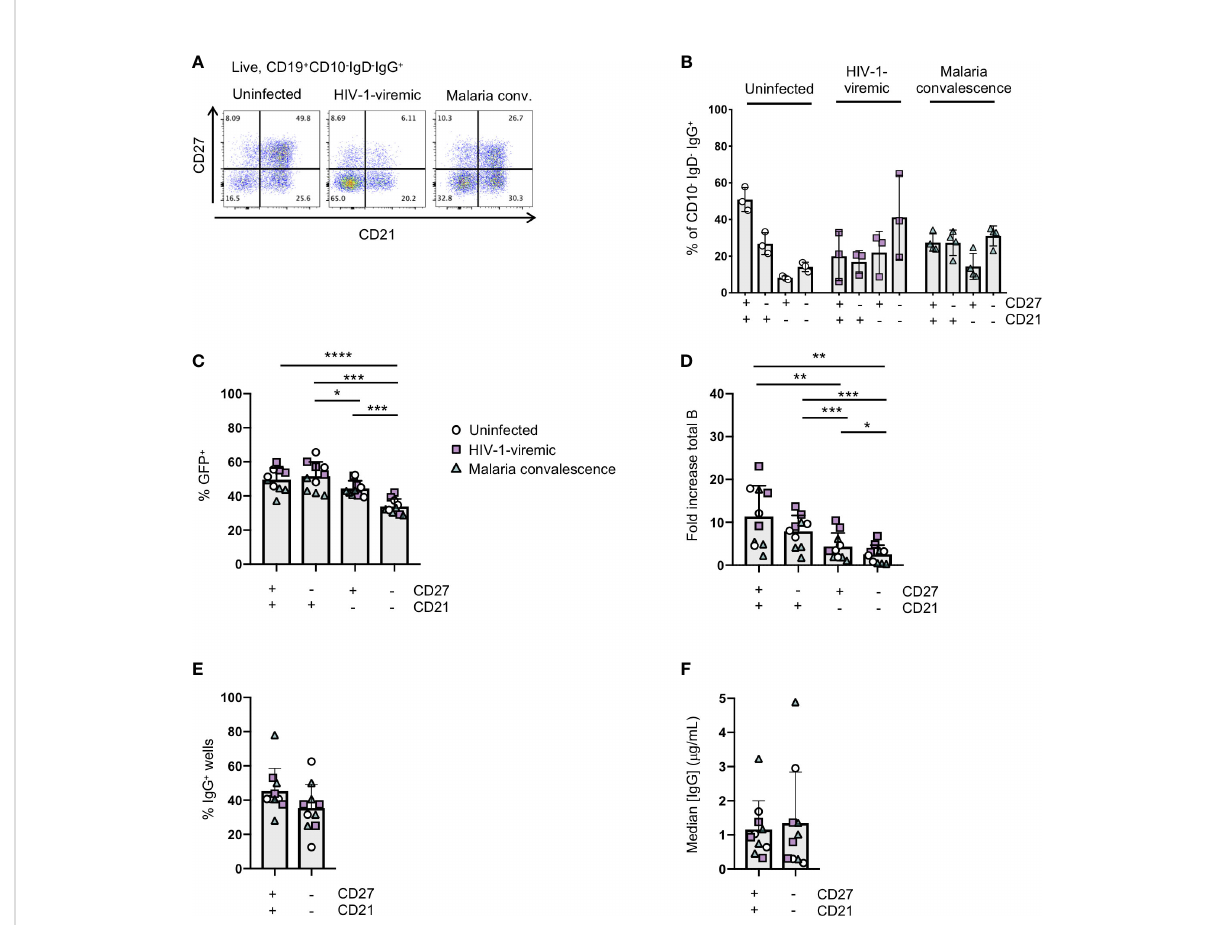
FIGURE 4 Immortalization of B cell subsets based on CD27 and CD21 expression in uninfected and HIV-1-viremic individuals and individuals treated for malaria. (A) Representative fl ow plots indicating the frequencies of CD27+CD21+, CD27-CD21+, CD27+CD21+ and CD27-CD21-B cells within the IgG+ B cell subset from PBMC for uninfected (n=3), HIV-1- viremic (n=3) and following malaria infection (n=4). (B) Quantitation of subsets based of the expression of CD27 and CD21 within the IgG+ B cell subset. (C) Frequency of GFP+ B cells 4- days post-transduction for each isolated subset. (D) The fold-increase in total B cell number during activation and transduction for the isolated B cell populations over 6 days. (E) The frequency of wells with supernatants containing IgG was determined by ELISA after 24 days of culture. (F) The median IgG concentration within the IgG wells. Comparison between groups was performed by one-way ANOVA with signi fi cance determined by Tukey's multiple comparisons test. ****p<0.0001; ***p<0.0005; **p<0.005;